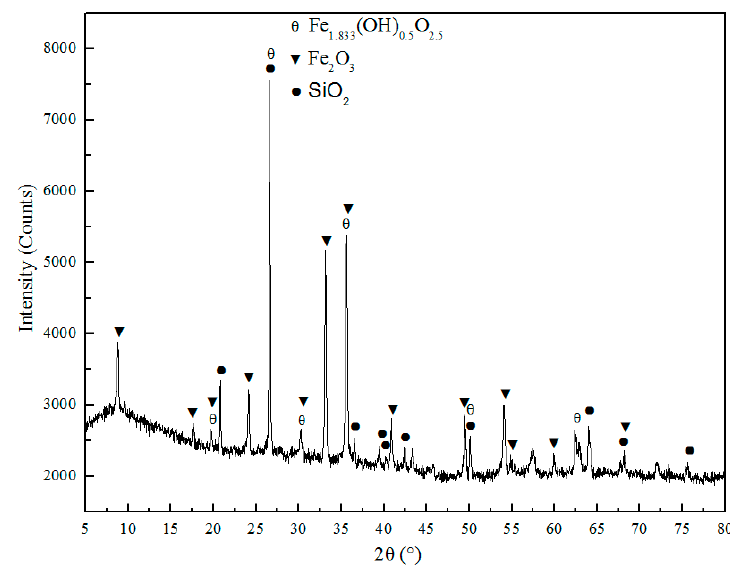
Figure 1. XRD pattern of cyanide tailings.